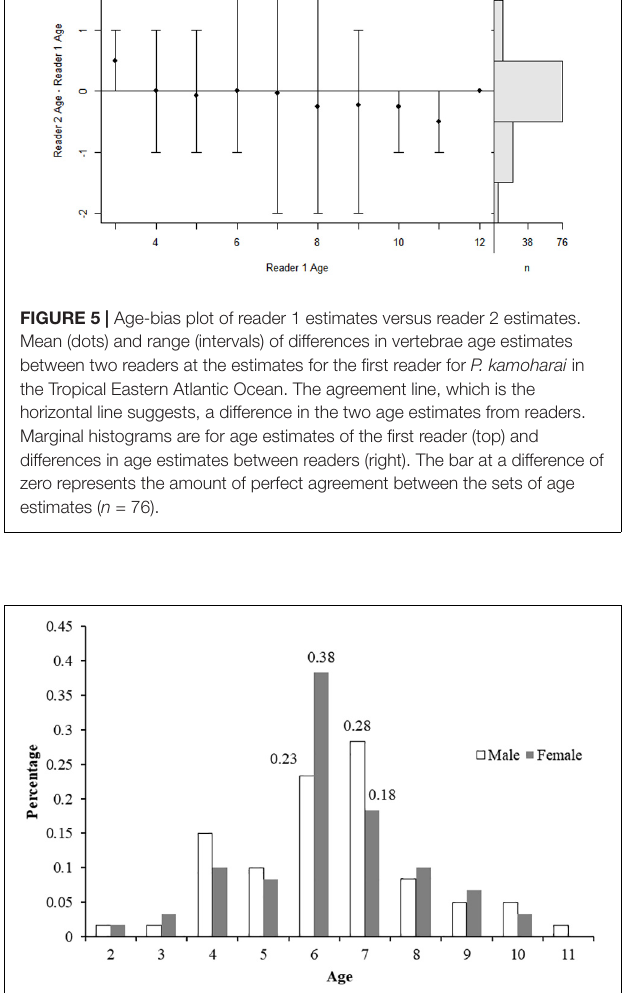
yearly growth increments G indicated similar growth between sexes. For both sexes, growth was greatest in the first three years after birth ( Supplementary Table 1 ).